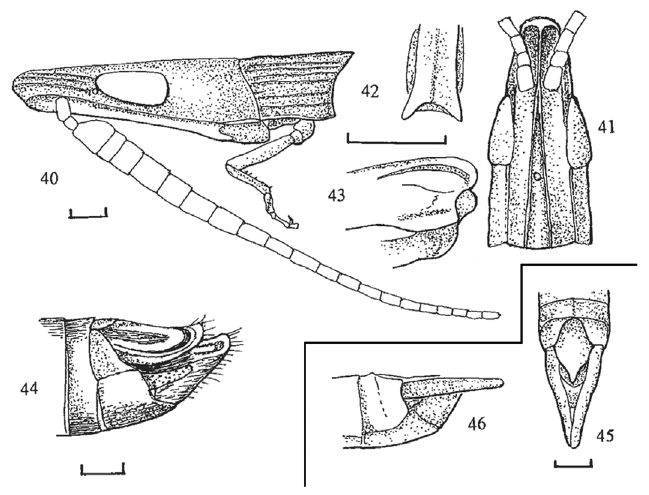
Figs 40–46. Cannula-Glyphoclonus-Cumulus genus group. Figs 40–44. Male Culmulus stramineus Uvarov, 1953. 40. Lateral aspect head and pronotum from left side; 41. Anatomy of frons and fron- tal ridge; 42. Left posterior femoral apex from above; 43. Same as 42, from the side; 44. Abdominal apex, oblique view from left side. Figs 45, 46. Male Gonista longicercata (Bouvy, 1982): 45. Ab- dominal apex from above; 46. Abdominal apex from left side.